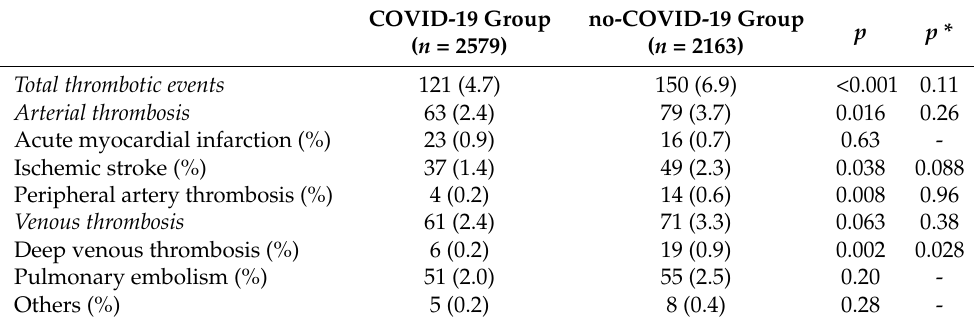
Table 2. Arterial and venous thrombosis in COVID-19 and no-COVID-19